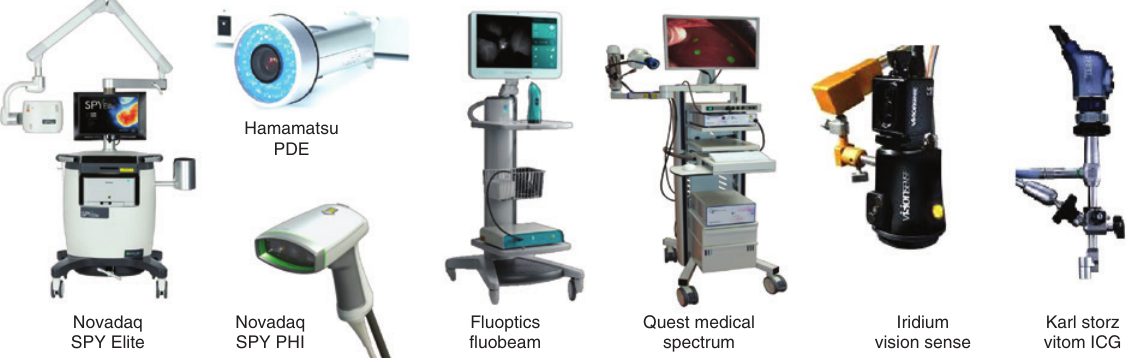
Figure 3: Commercially available open-air NIR fluorescence imaging systems for image-guided surgery. Shown are representative images of SPY Elite (Novadaq), PDE (Hamamatsu), SPY PHI (Novadaq), Fluobeam (Fluoptics), Spectrum (Quest